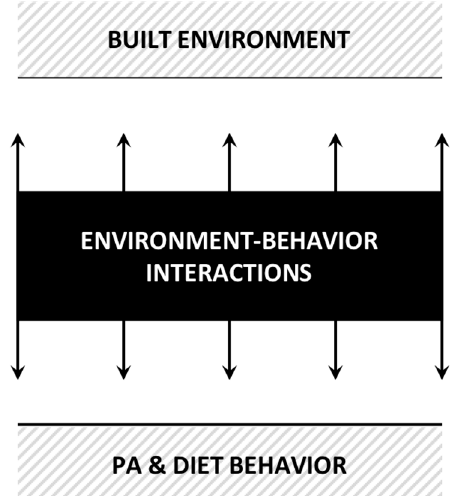
Figure 1. Black box of interactions: the focus of the scoping review.